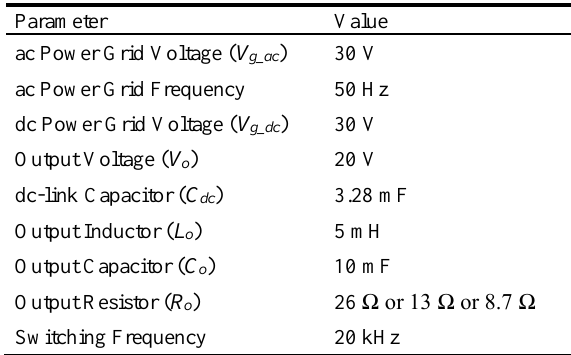
Figure 6. Laboratory workbench used for obtaining the experimental results. Table 3. Experimental setup